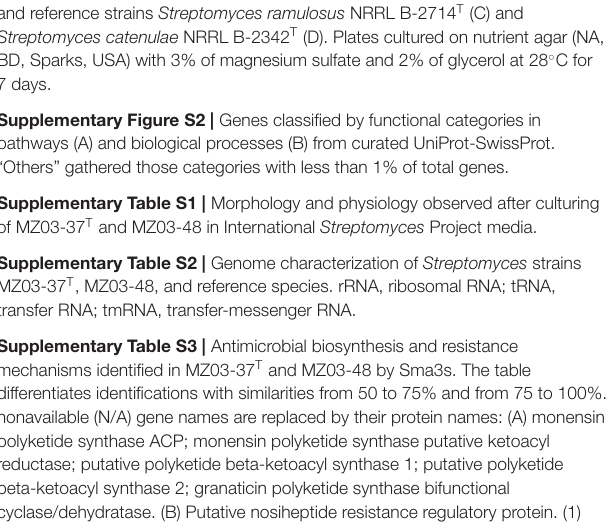
Supplementary Figure S2 | Genes classified by functional categories in pathways (A) and biological processes (B) from curated UniProt-SwissProt. “Others” gathered those categories with less than 1% of total